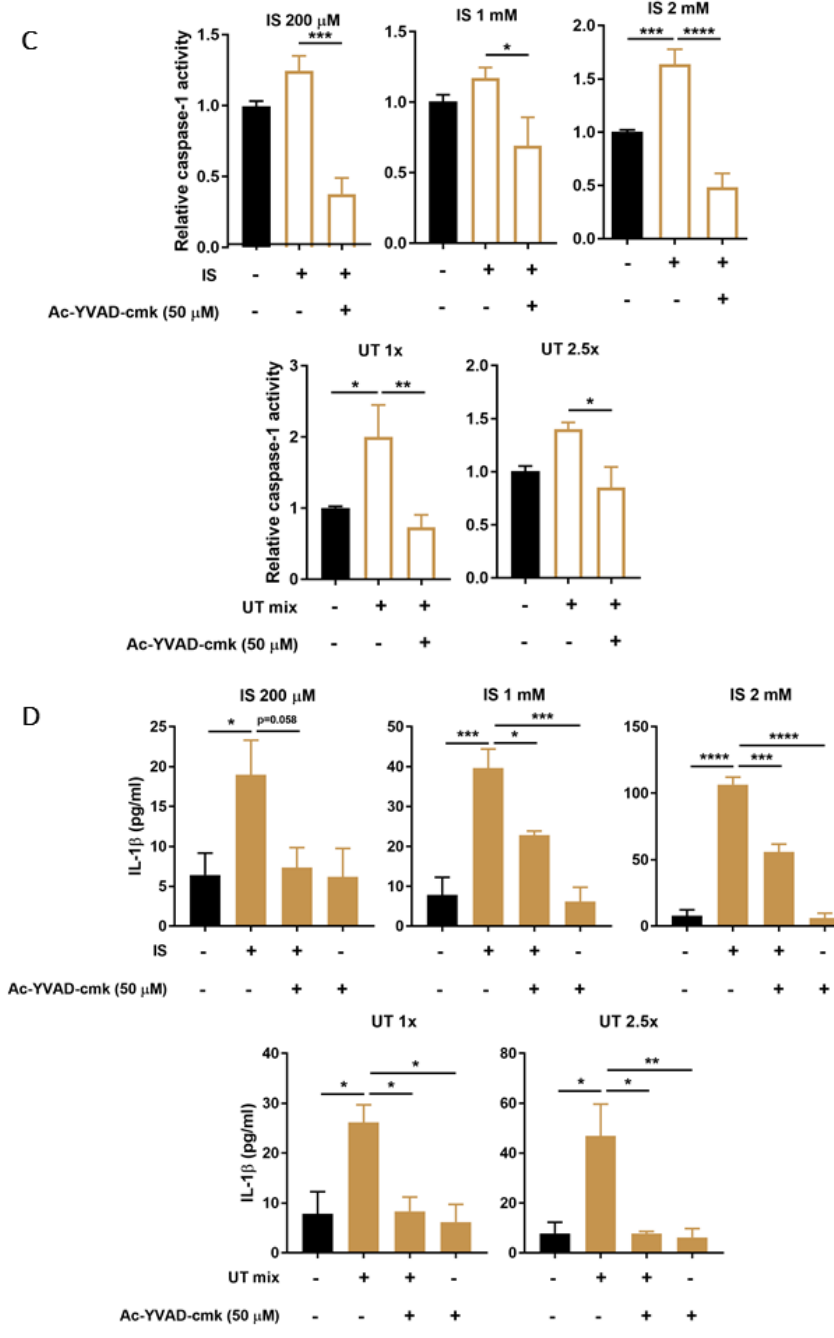
Figure 3. Effect of PBUTs on protein levels or functional activity of NLRP3 inflammasome-related components in ciPTEC-OAT1. Representative Western blot and quantification of relative expression of ( A ) NLRP3 and ( B ) ASC in ciPTEC-OAT1 following 24 h exposure to IS (200 µ M, 1 mM, 2 mM) and UT mix (1 × , 2.5 × ); normalized to β -actin. ( C ) Relative caspase-1 activity in ciPTEC-OAT1 upon 2 h exposure to IS (200 µ M, 1 mM, 2 mM) and UT mix (1 × , 2.5 × ), in the absence or presence of specific caspase-1 inhibitor, ac-YVAD-cmk (50 µ M). ( D ) IL-1 β secreted levels (pg/mL) by ciPEC-OAT1 upon 24 h treatment with IS (200 µ M, 1 mM, 2 mM) and UT mix (1 × , 2.5 × ), in the absence or presence of ac-YVAD-cmk (50 µ M). Data are derived from at least three independent experiments performed in triplicate and expressed as mean ± SEM. * p < 0.05, ** p < 0.01, *** p < 0.001, **** p < 0.0001 (One-way ANOVA followed by Dunnett’s multiple comparison test, using either untreated or PBUTs treated cells as a